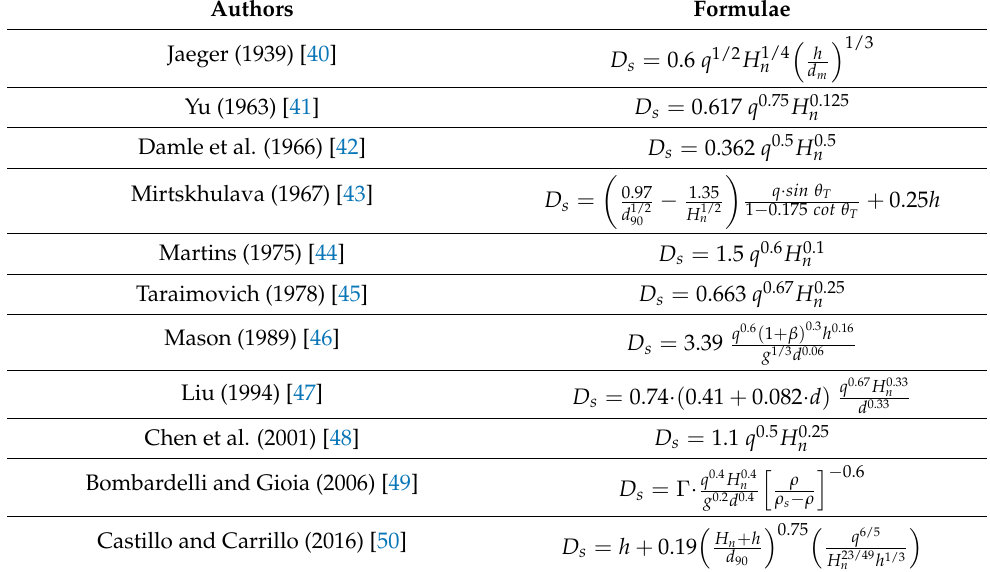
Table 4. General scour formulae.